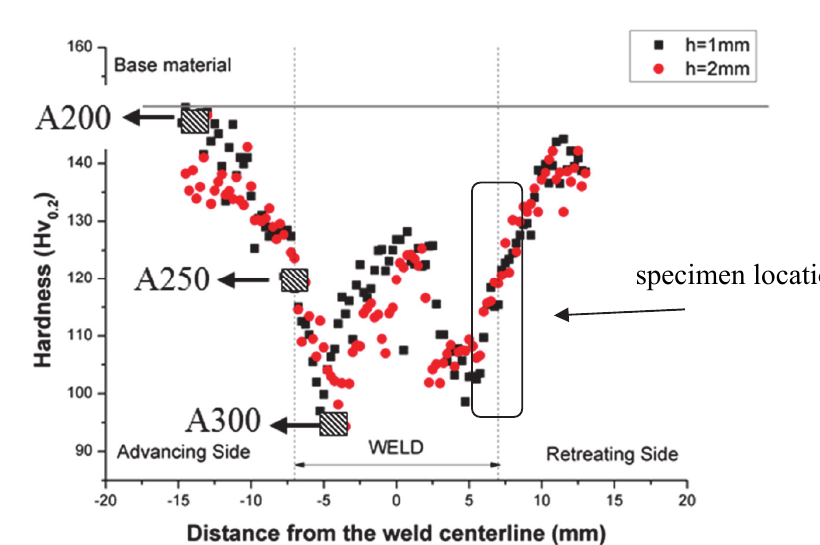
Figure 3: Microhardness variation in 2024 FSW determined at two different layers in the cross section of the FSW joint (1 and 2 mm depth from specimen surface). Local hardness values of A200, A250 and A300 materials are shown at the locations in the HAZ with similar microhardness values. The specimen location designates where the sample has been extracted to obtain local tensile properties in the